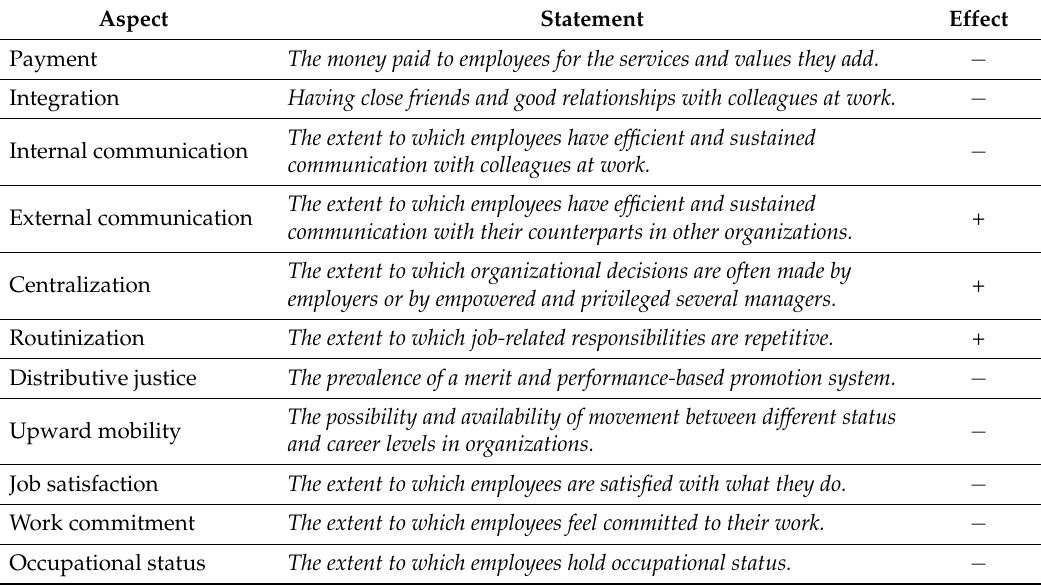
Table 1. Organizational causes of turnover intention (TI) and their presumed effects.